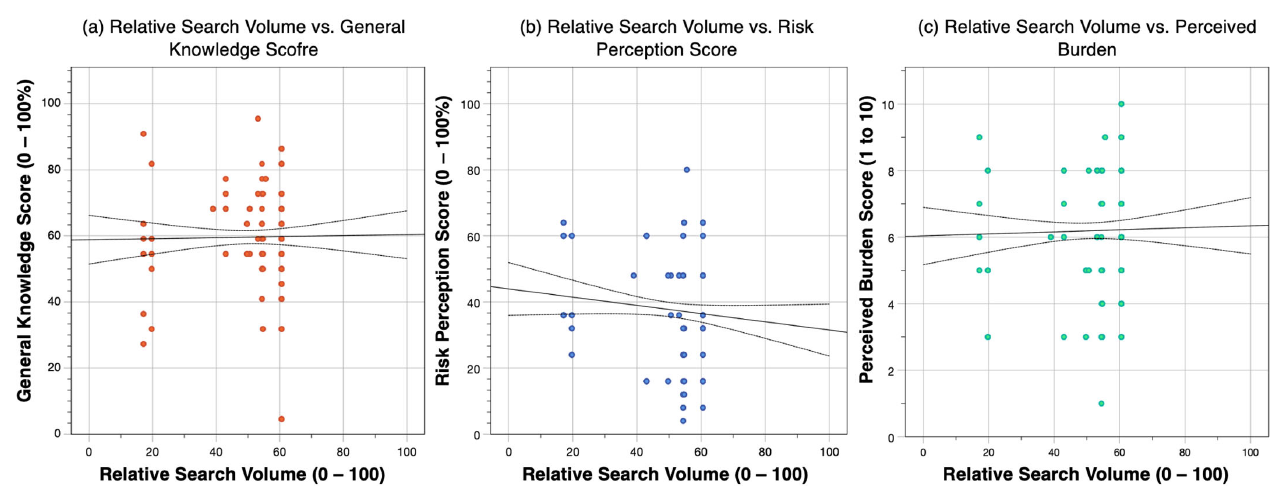
Figure A1. Correlation between relative search volumes (RSV) from Google Trends between 1 August and 10 September 2022 and: ( a ) general knowledge score (GKS, rho = − 0.078, p = 0.217); ( b ) risk perception score (RPS, Spearman’s rho = − 0.048; p = 0.451); ( c ) perceived burden of disease associated with West Nile virus infections (rho = 0.051; p = 0.419).